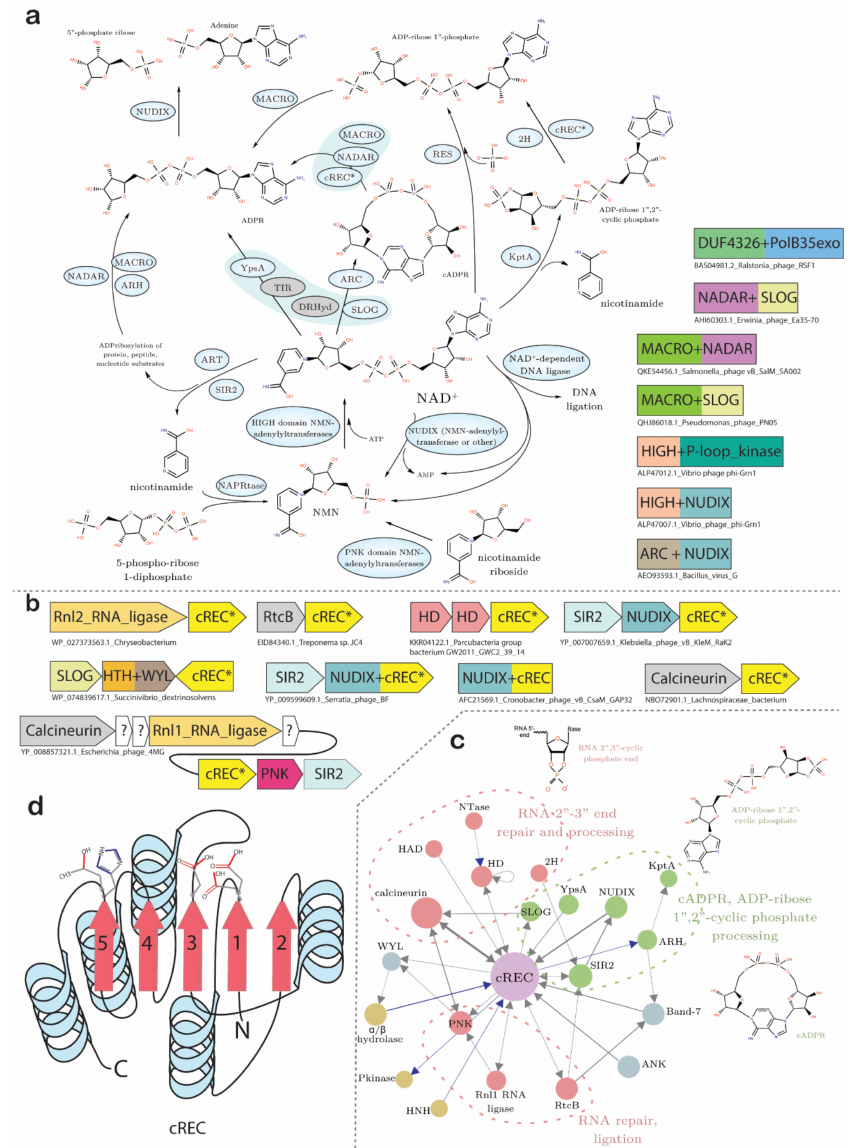
Figure 6. NAD + -centric conflict systems. ( a ) Biochemical action of various proteins involved in the NAD + -centric conflict systems and examples of interesting domain architectures of these proteins. ( b ) Gene neighborhoods of the cREC-containing systems and predicted topology of the cREC domain. Genes are represented as block arrows with arrow-heads pointing to the 3 (cid:48) ends of the gene. Neighborhoods and architectures are denoted by their accession numbers and phage names separated by underscores. The accession number in the label corresponds to the gene marked with a *. ( c ) Contextual network of the cREC domain derived from gene neighborhoods and domain architectures. Gene neighborhood associations are depicted with black lines with the arrowhead pointing to the 3 (cid:48) gene and domain associations with blue lines with the arrowhead pointing to the C-terminal domain. Distinct domains in architecture representations are colored differently. Nodes in the same functional category are colored similarly and grouped. ( d ) The topology of the cREC domain was predicted based on the know Receiver domains. The conserved residues were then superimposed onto the topology based on the cognate positions of conserved residues observed in classical Receiver